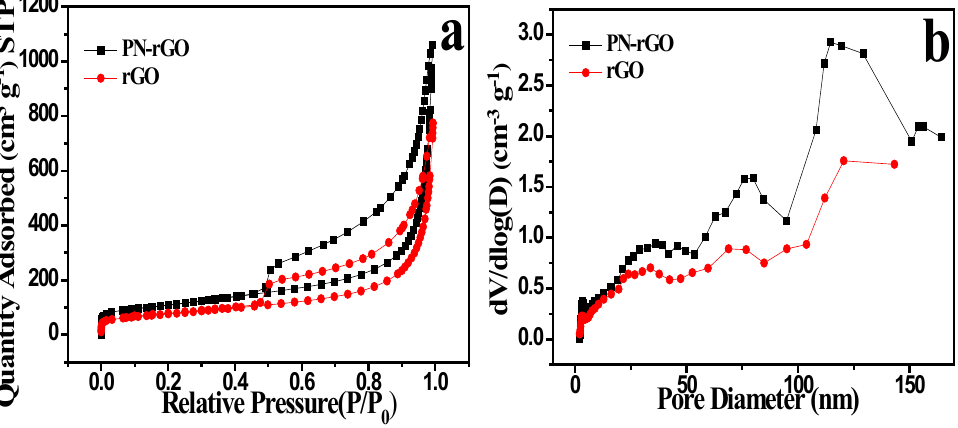
Figure 3. Nitrogen adsorption-desorption isotherms ( a ) and the corresponding pore size distribution curve of PN-rGO and rGO ( b